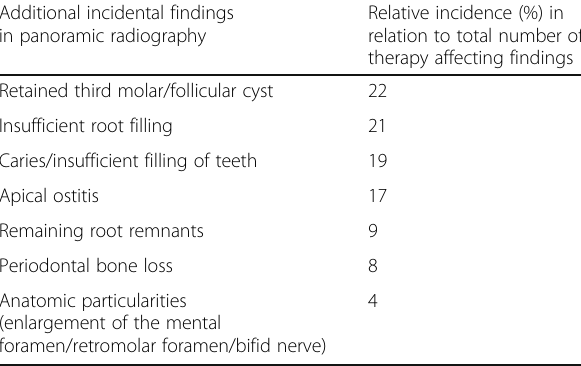
Table 4 Description of incidental findings in PAN not related to